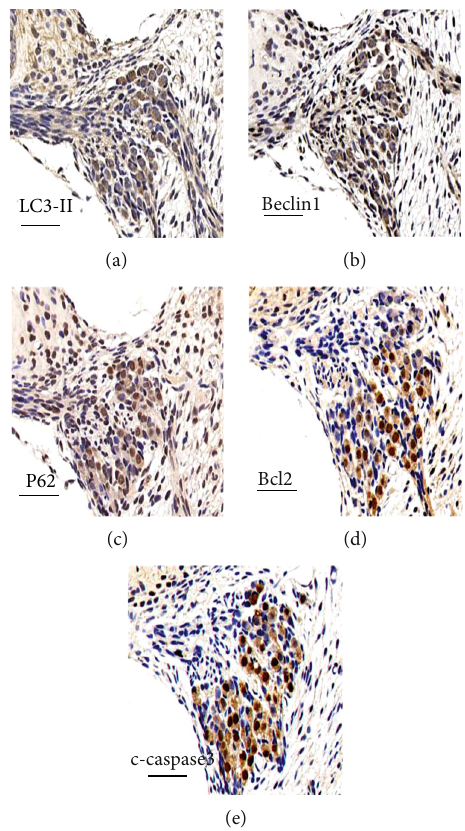
Figure 3: Immunohistochemical staining for autophagy and apoptosis-associated genes at P7. (a), (b) (c), (d), and (e) represent immunohistochemical staining for LC3-II, Beclin1, P62, Bcl-2, and cleaved-caspase3, respectively. The images were obtained from the middle turn of rat cochlea. In the area of SGNs, a positive brown staining was observed in the cytoplasm or nucleus. Scale bars = 50 μ m